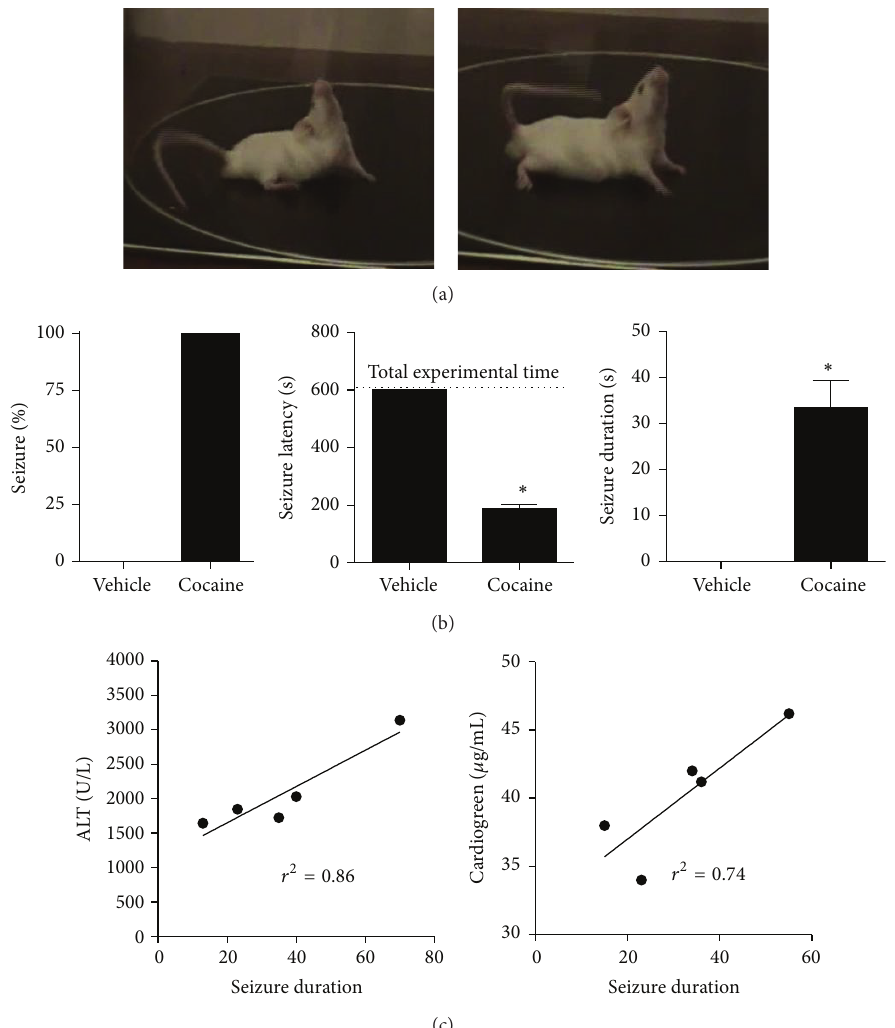
Figure 3: High doses of cocaine promote acute behavioral seizure. (a) Representative picture of seizure characterized by rapid myoclonic convulsions of forelimbs and tail clonus preceded by locomotor depression. (b) Acute overdose induced seizure in all animals represented by latency reduced and duration increased compared to group vehicle. (c) Positive correlation between seizure duration and acute hepatotoxicity inducedbycocaine( 𝑟 2 = 0.86 , 𝑃 < 0.02 forALT; 𝑟 2 = 0.74 , 𝑃 < 0.05 forcardiogreen). ∗ Significantlydifferentfromvehiclegroup( ∗ 𝑃 < 0.001 ). One-way ANOVA with Tukey’s post hoc test. Data are expressed as mean ± S.E.M ( 𝑛 = 6